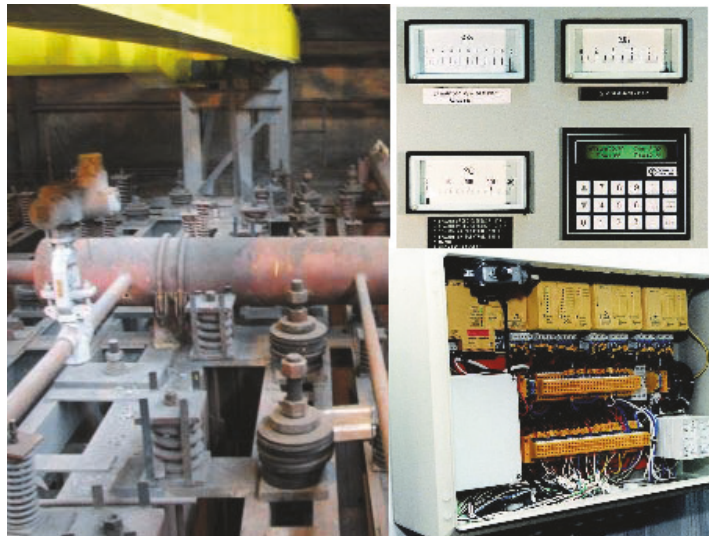
Figure 3: The steam reheater outlet header and the control panel with the data acquisition system.